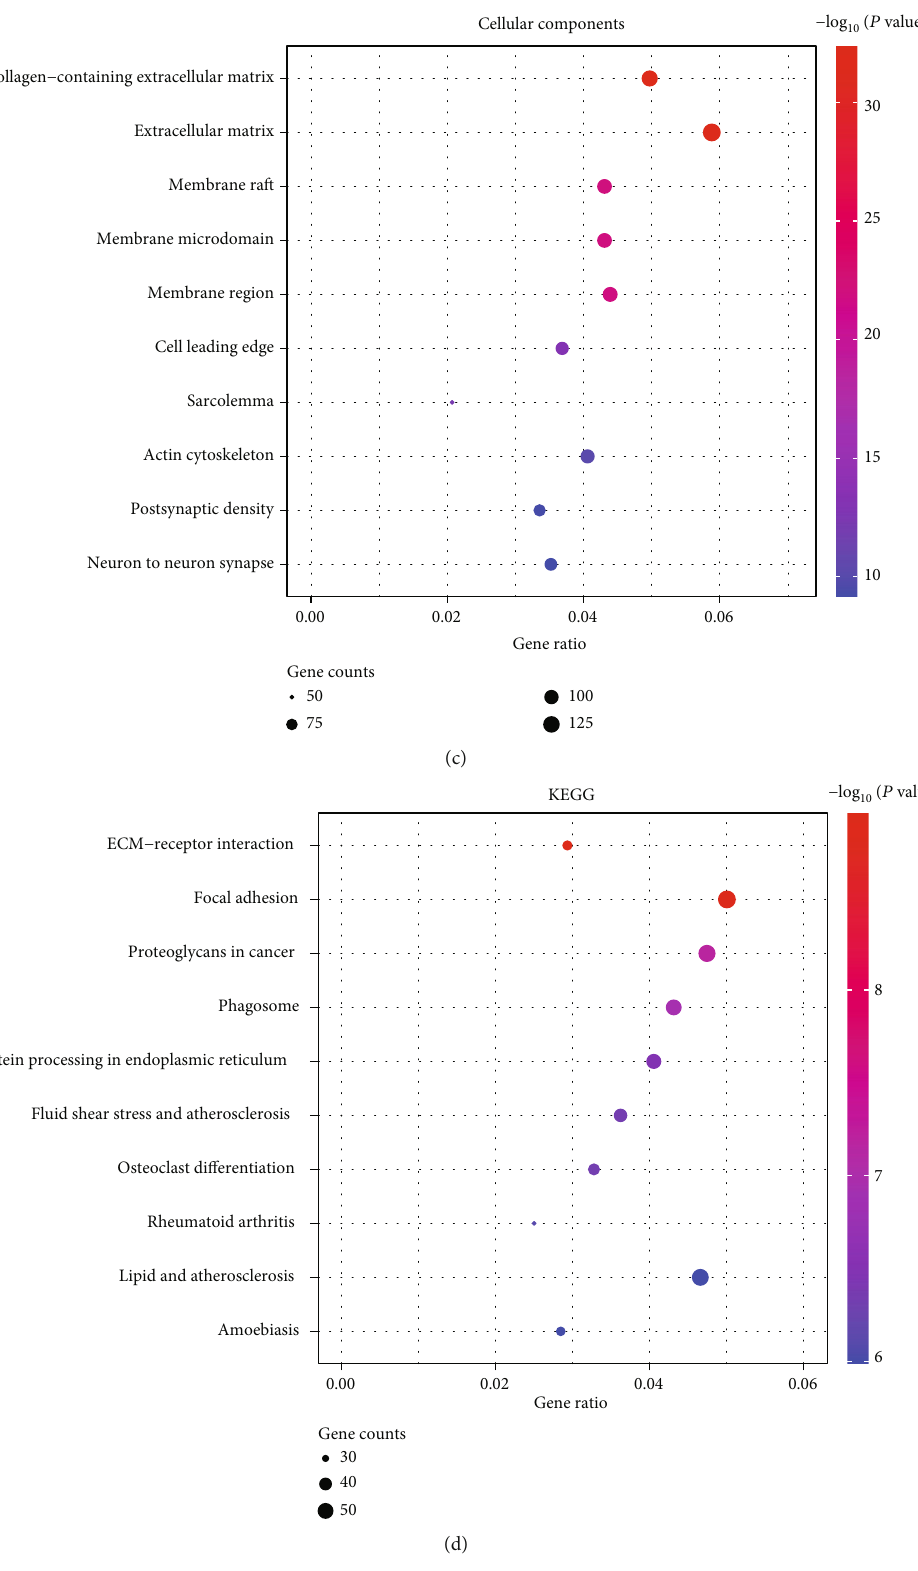
Figure 2: Functional enrichment analyses of the DEGs. (a) – (c) The top 10 enriched biological process (BP) (a), molecular function (MF) (b), and cellular component (CC) (c) of the common DEGs. (d) The KEGG pathway analysis of the common